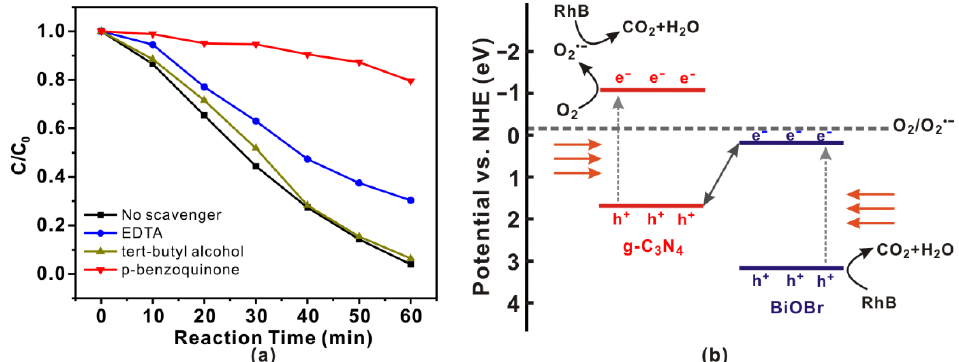
Figure 8. ( a ) The photodegradation of Bpg-C 3 N 4 -0.75 with different scavengers; ( b ) schematic illustration of the photodegradation of RhB over BiOBr/g-C 3 N 4 .